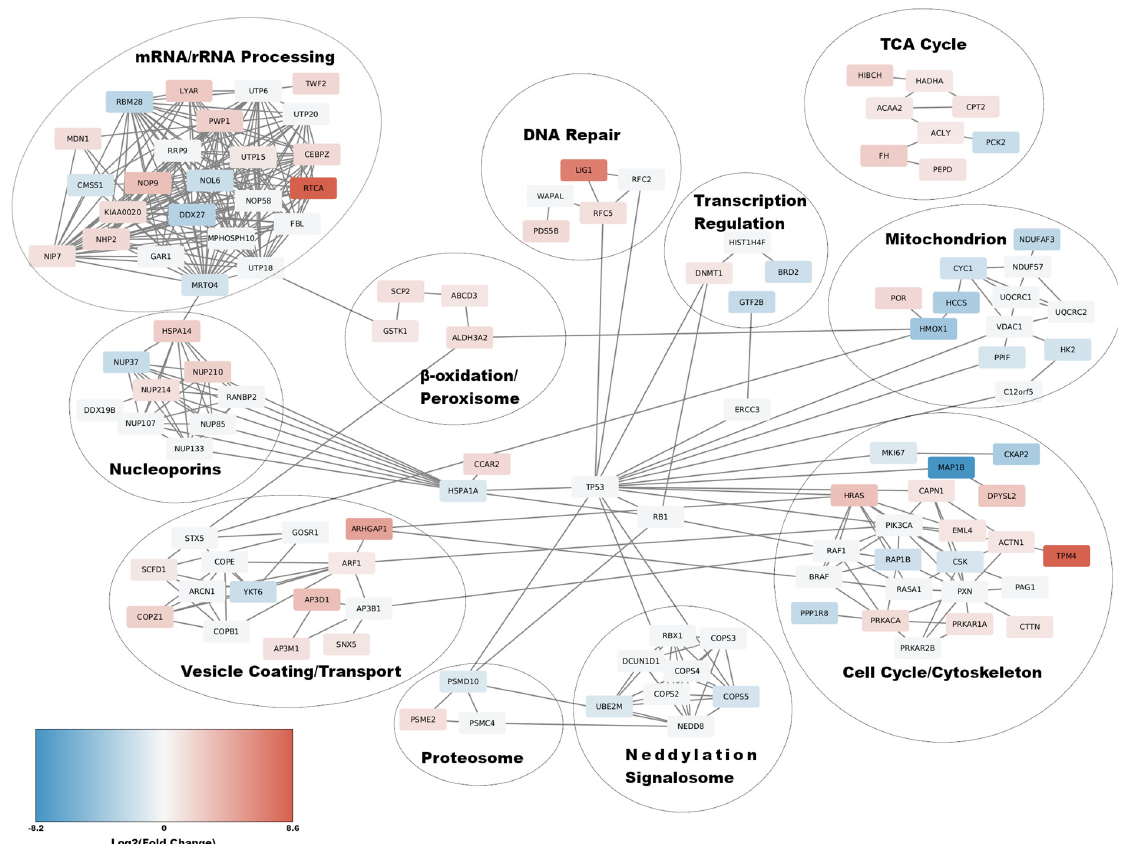
Figure 3. Functional Network Enrichment to the DEPs of the L sample by STRINGDB. The dif- ferentially expressed proteins include only high confidence entries (significance > 0.7). Red boxes: up-regulated proteins; blue boxes: down-regulated proteins; white boxes: first neighbors. Scale bar, log2